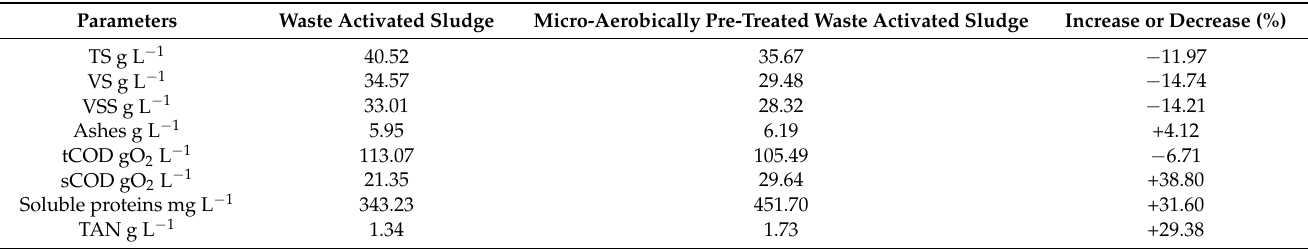
Table 2. Variation in different parameters during the micro-aerobic